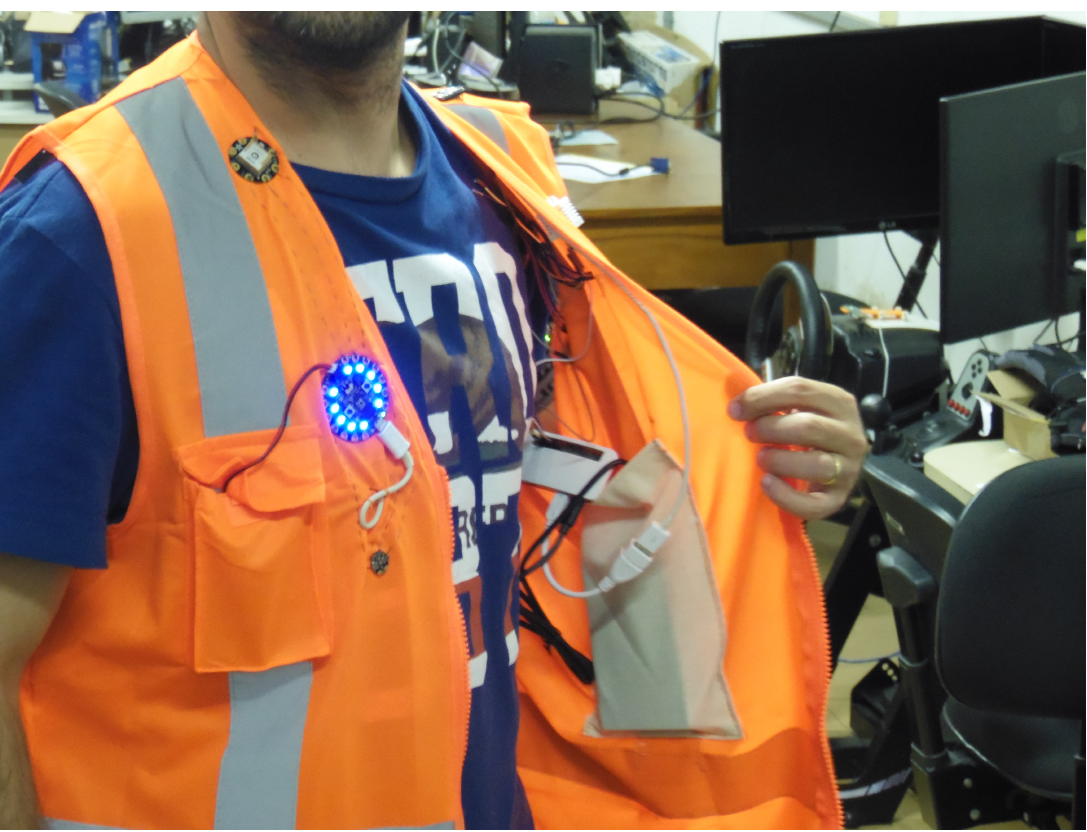
Figure 2. Wearable Device Prototype, proposed in